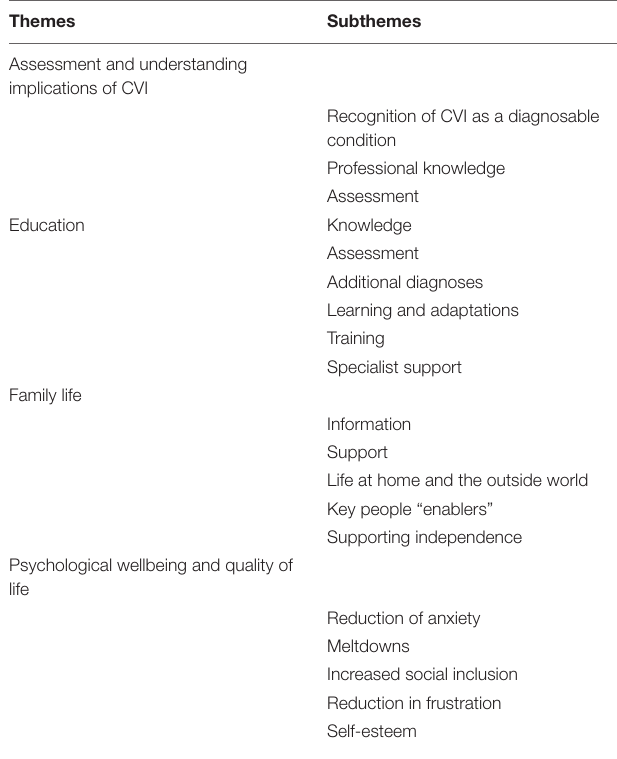
TABLE 1 | Ages of the children described in the parent interviews and reported diagnosis of cerebral palsy or registered as partially sighted/blind. Ages of children Number of children in who were the each age group focus of parent interviews